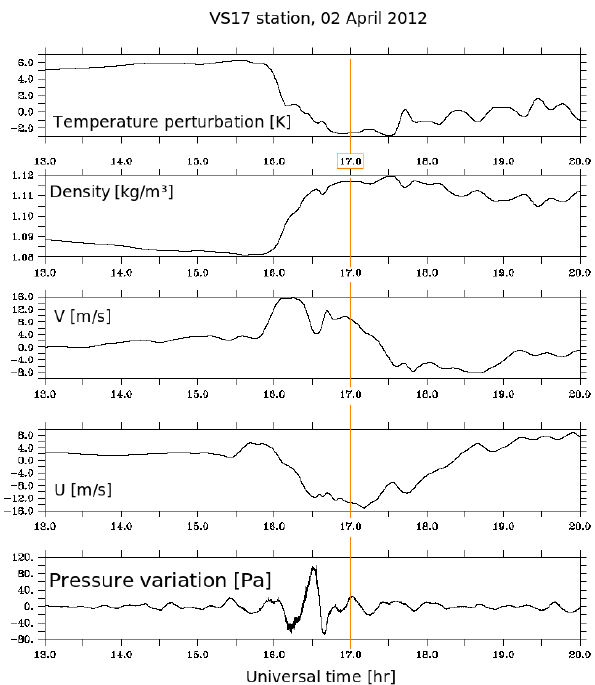
Fig. 8. Real simulation. Time records of temperature perturbation [K], density [kgm − 3 ], horizontal V - and U -wind velocity [ms − 1 ], and pressure variation [Pa] retrieved at 100m altitude above the vir- tual station VS17, on 2 April 2012. Variable perturbation and vari- ation are defined as in Fig. 3 and Fig. 4,